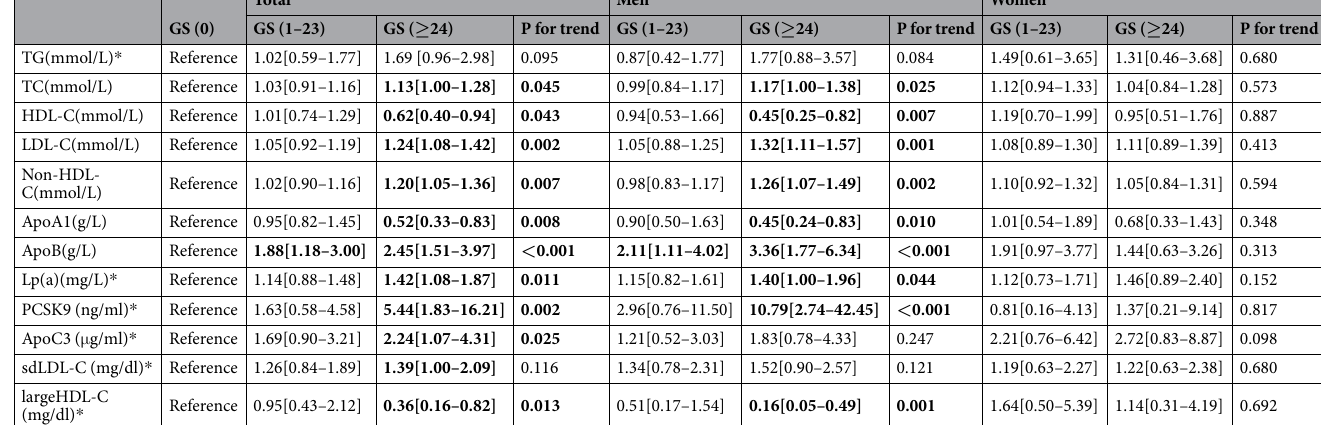
Table 3. Associations of lipid biomarkers with coronary severity using logistic regression analysis. Multiple logistic regression analyses were performed and ORs [95% CIs] were showed with adjustment for age, gender, hypertension, HbA1c, current smoking and hs-CRP. The bold values indicated statistical significance and were bolded to improve the readability of the table. * Log-transformed data. Abbreviations as Table 1.